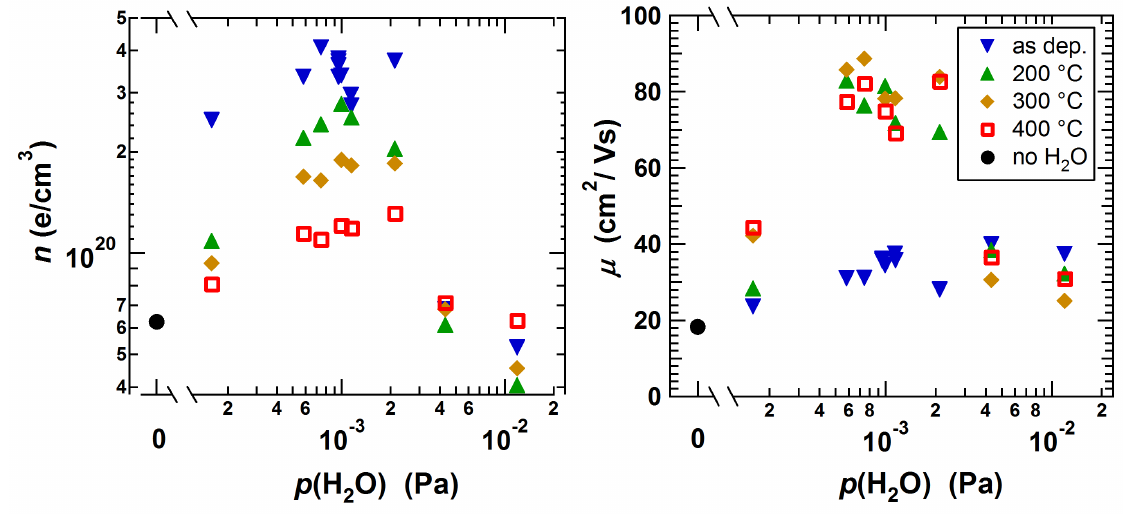
Figure 1. Hall effect measurements of In O :H films deposited with varying water vapor 2 3 partial pressure and subsequently annealed at different temperatures. The circles correspond to non-annealed In O film deposited at room temperature (RT) without additional H 2 3